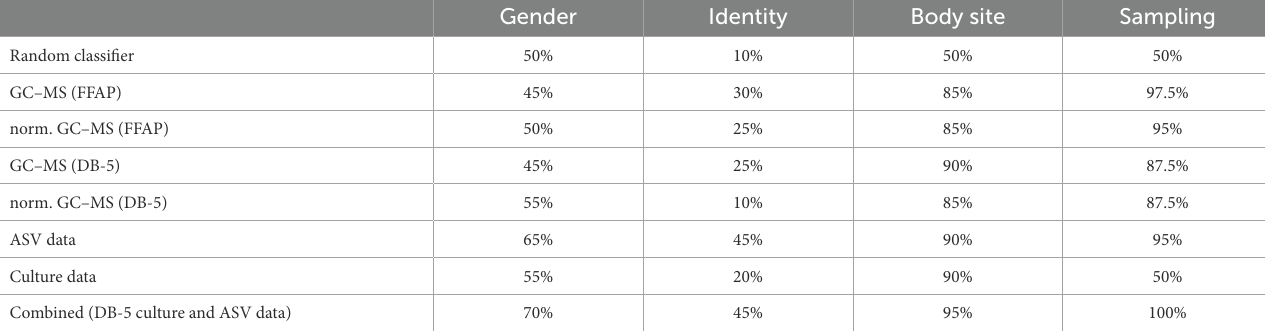
TABLE 1 Classification accuracy for different meta data and data sources in %. Results are from a random forest classifier trained on the first sampling and evaluated on the second sampling. To evaluate the accuracy for identifying the different samplings a leave-one-out cross-validation was performed on all 40 subjects (right-most column). The results from a random classifier are shown for